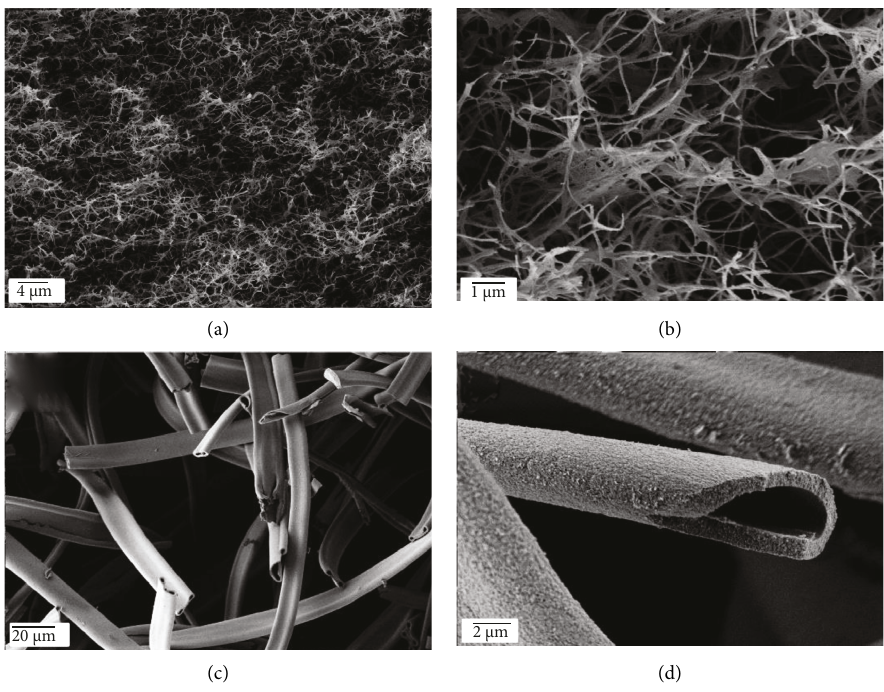
Figure 5: Structural morphology of TiO2 ALD-coated nanocellulose samples after pyrolysis (a) and (b). In (c) and (d), the morphology of TiO 2 coated Kynol samples after burnout in air, where a straw-like structure can be seen.